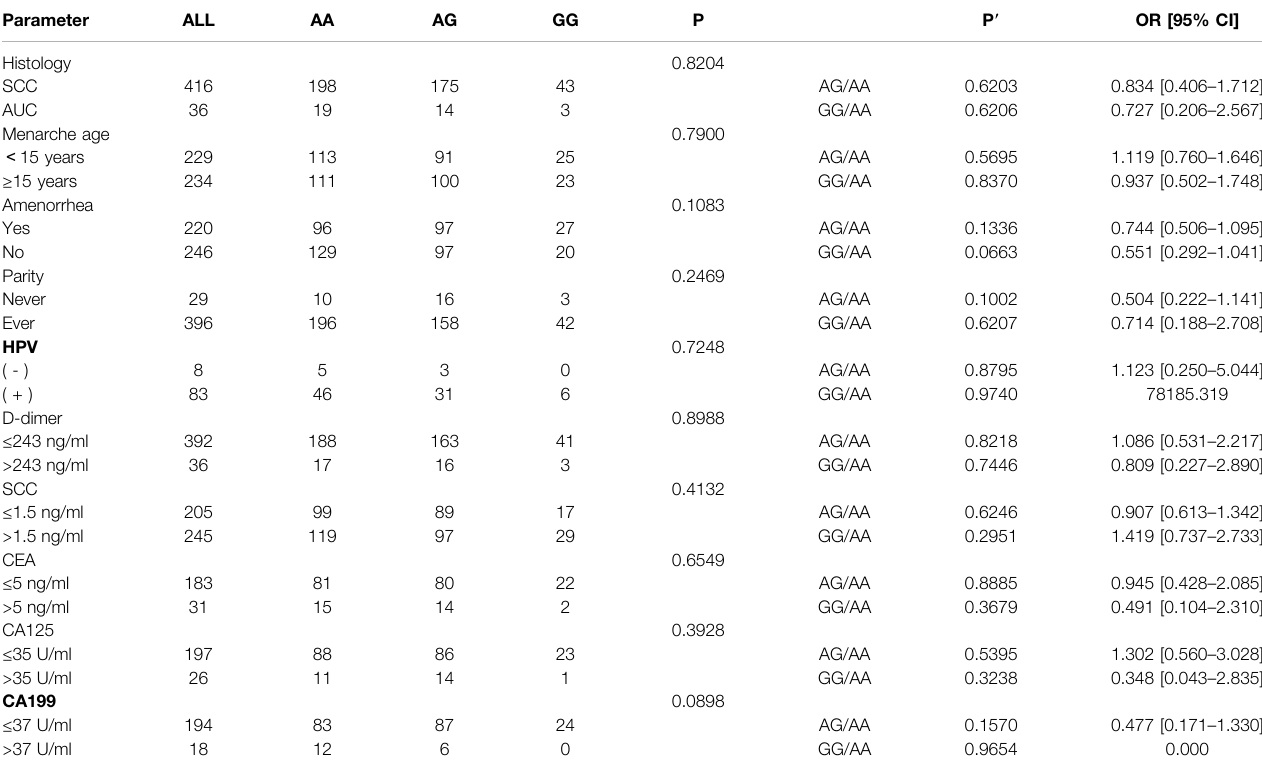
TABLE 7 | Comparison of genotype distribution frequencies with clinical parameters in the CC group. Parameter